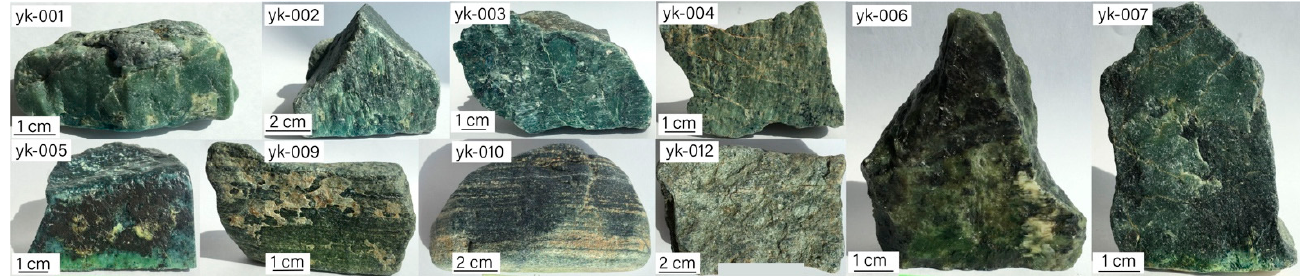
Figure 2. Photos of 10 “Laoshan Jade” samples. The color of “Laoshan Jade” is from green to dark green, distributed unevenly,